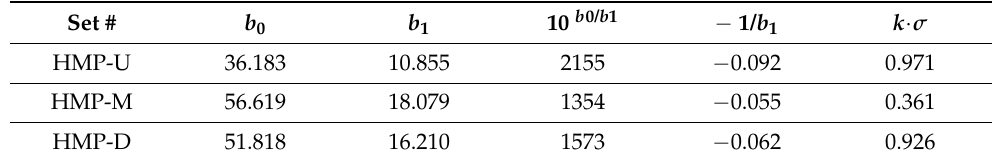
Figure 5. S-N curves with related confidence bands for sets ( A ) HMP-U, ( B ) HMP-M, and ( C ) HMP-D. Table 3. S-N curves in the finite life domain: related coefficients for nominal trend and confidence